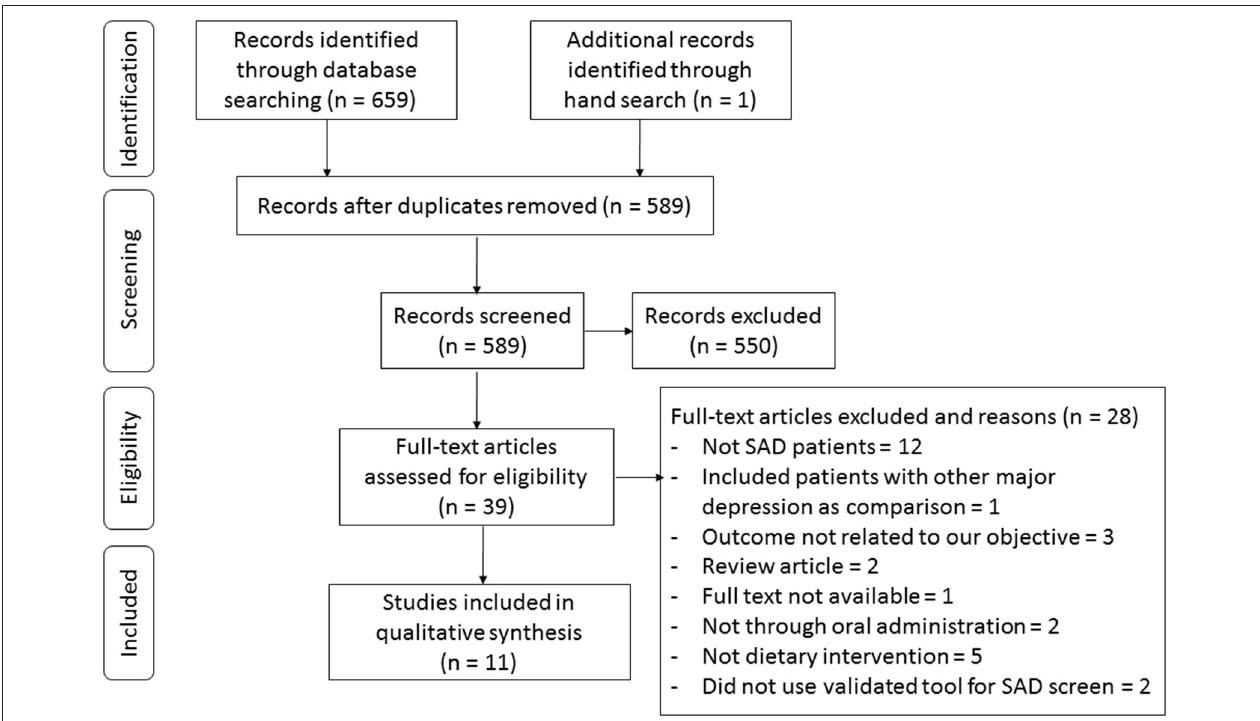
FIGURE 2 | Flowchart of study selection according to the PRISMA